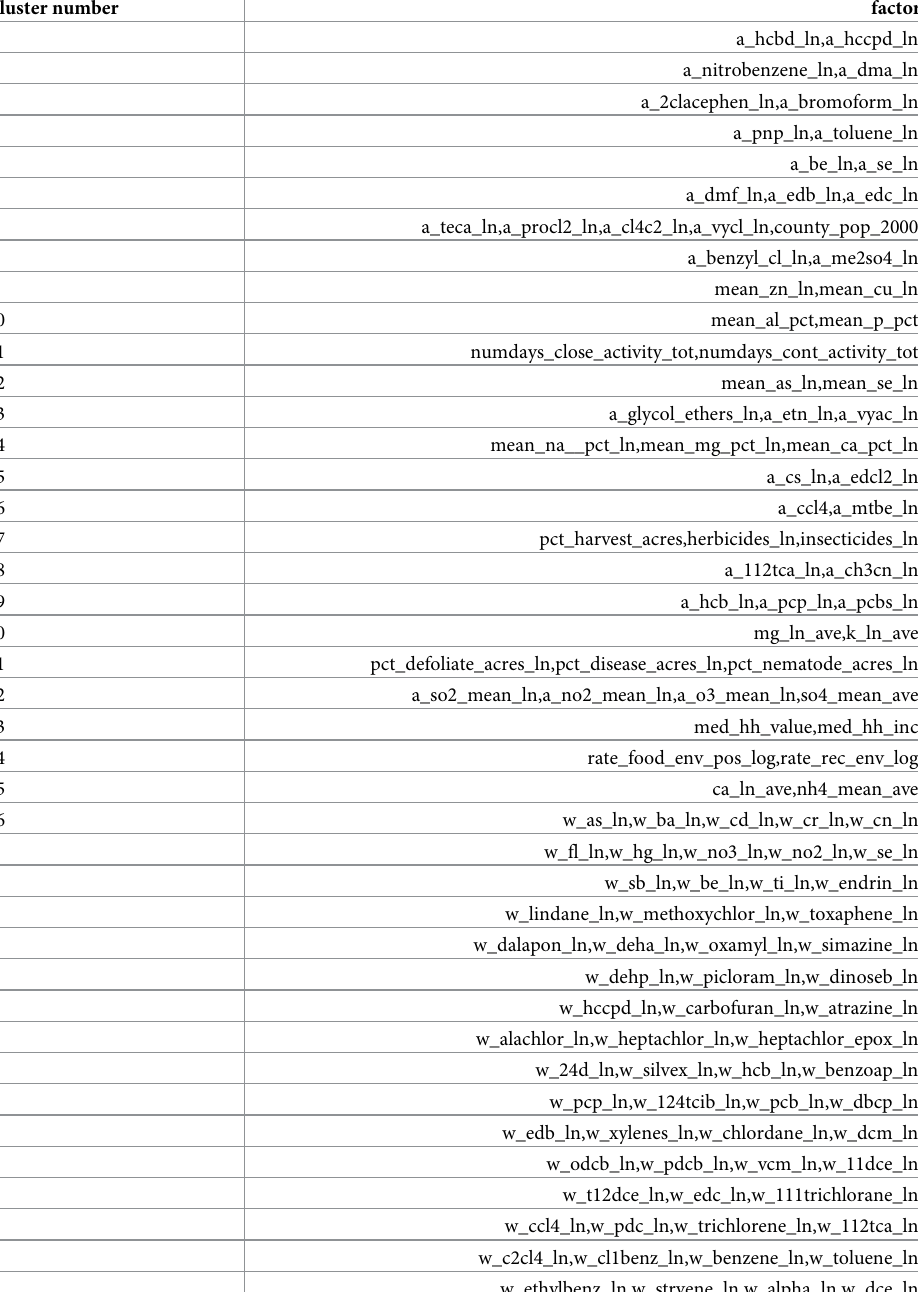
Table 2. Pollutant clusters discovered by applying the Ward’s method to the EQI raw measurements dataset. Cluster number